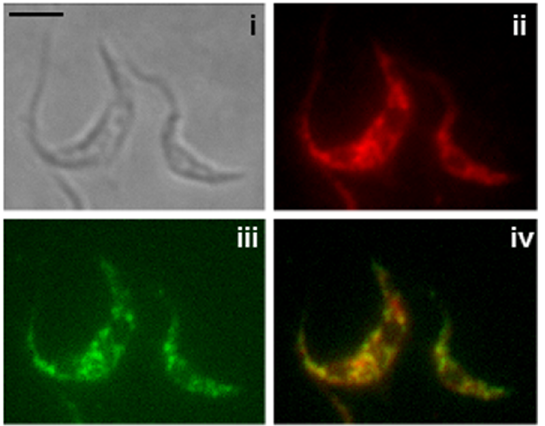
Fig 3. V5: Tb DAT localizes to the glycosome. A V5-tagged version of Tb DAT was expressedin the null mutant Δ tbdat/ Δ tbdat background. Immunofluorescence assay in the presence of anti-V5 monoclonal antibodies (ii) and glycosome specific antiserum [37] (iii). i, DIC; iv, overlap of ii and iii. The bar represents 10 μ m.